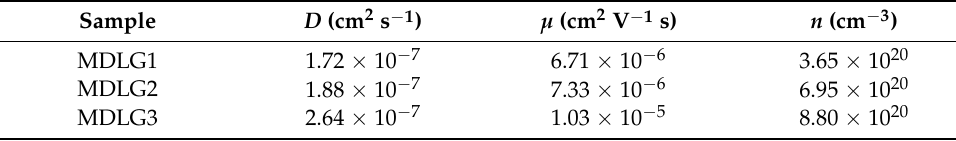
Table 4. The values of ion transport parameters of each film from impedance approach.